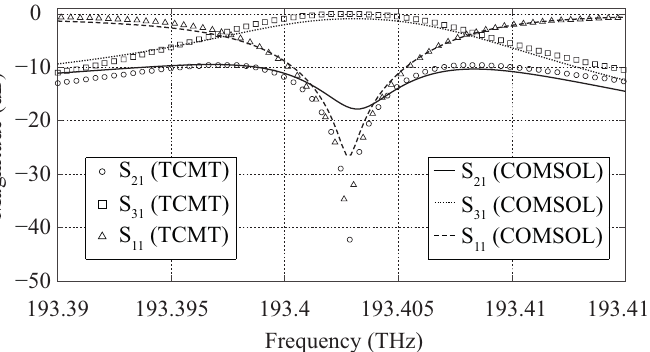
Figure 12. S-parameters of the circulator obtained from TCMT equations and 2D simulations with COMSOL Multiphysics.